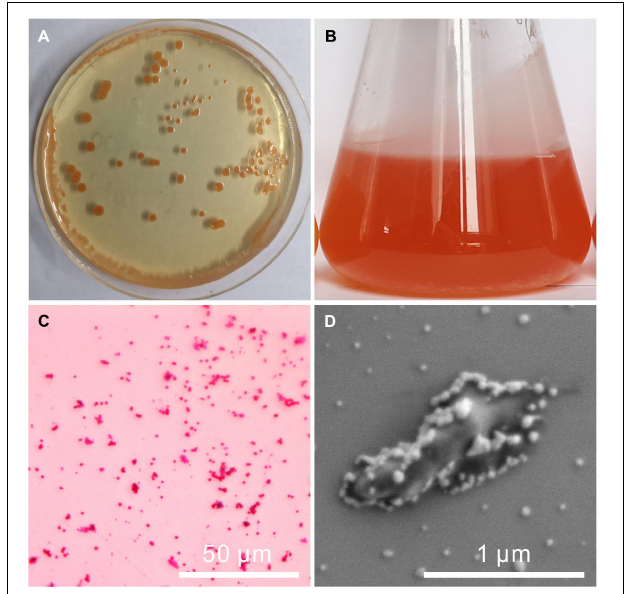
FIGURE 1 | Images of the colony, seed liquid, and a single cell of Vibrio harveyi QPL2. (A) Colonies of QPL2 on a solid medium; (B) culture medium of QPL2 showing orange color and bacterially-induced precipitates; (C) negative gram-staining results; and (D) single cell of QPL2.